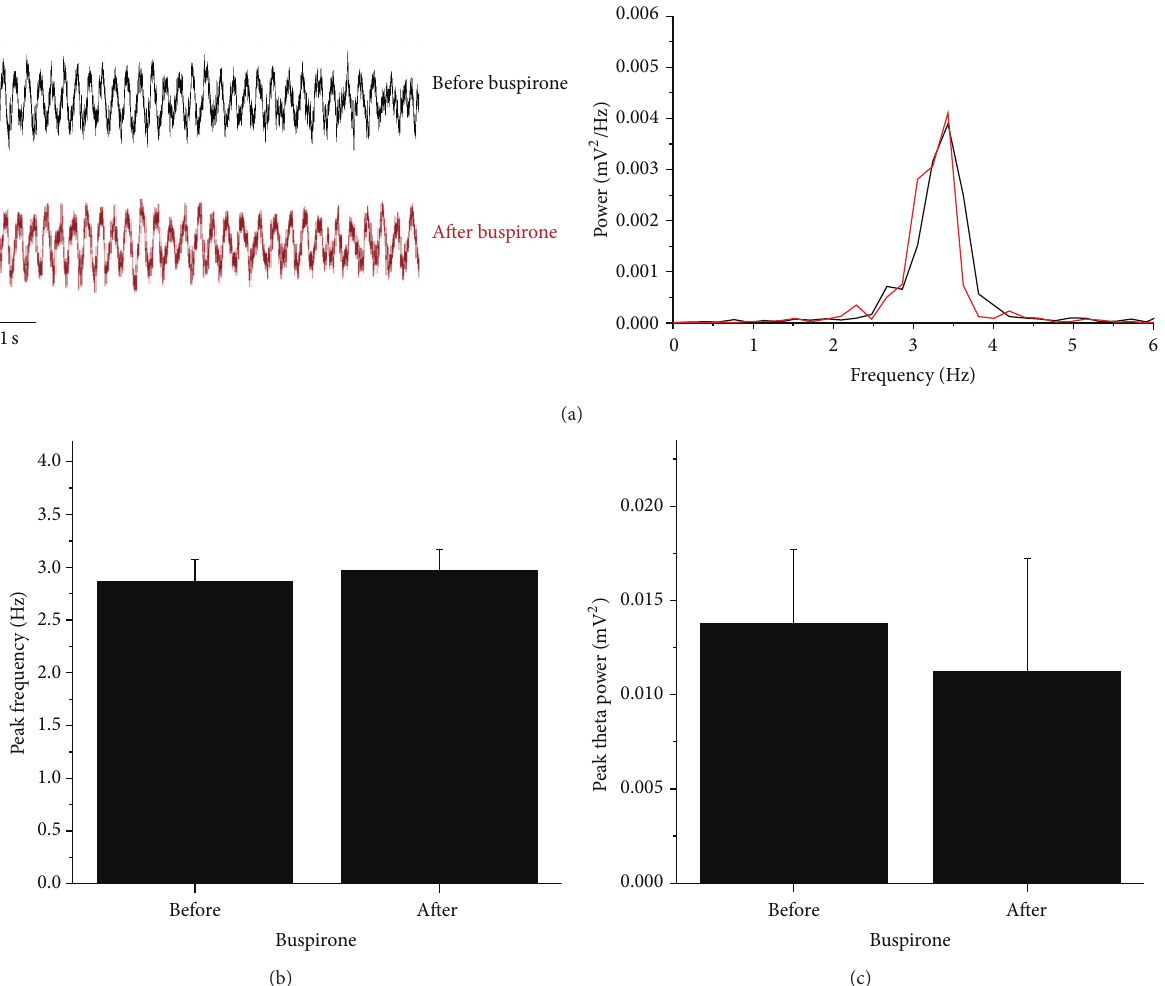
Figure 5: Representative local field potential traces showing activity before (black) and after (red) buspirone administration in the nAX mice (a). Power spectra of the two illustrative traces do not indicate change after buspirone. Buspirone did not change the peak frequency of evoked oscillation (b) nor did it change the peak power of theta (c). Calibration bars are 1sec. and 0.3 mV. networks were also shown to regulate hippocampal PPF